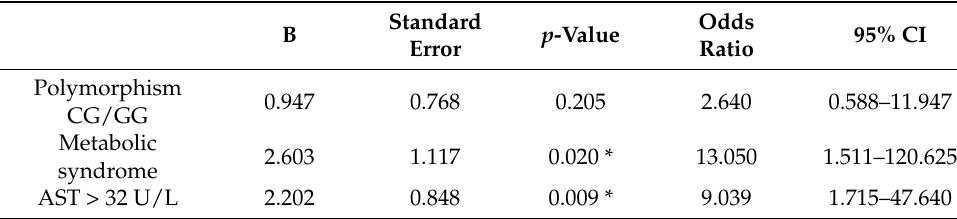
Table 3. Age-adjusted beta coefficients (B), standard errors, p -values, odds ratios and confidence intervals (95% CI) for advanced fibrosis